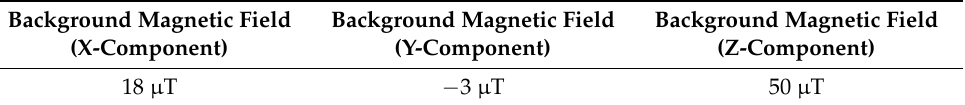
Table 2. Background magnetic field (magnetic field of the Earth): from August 2016 to August 2017 (Adapted from Natural Resources Canada (http://www.nrcan.gc.ca)).